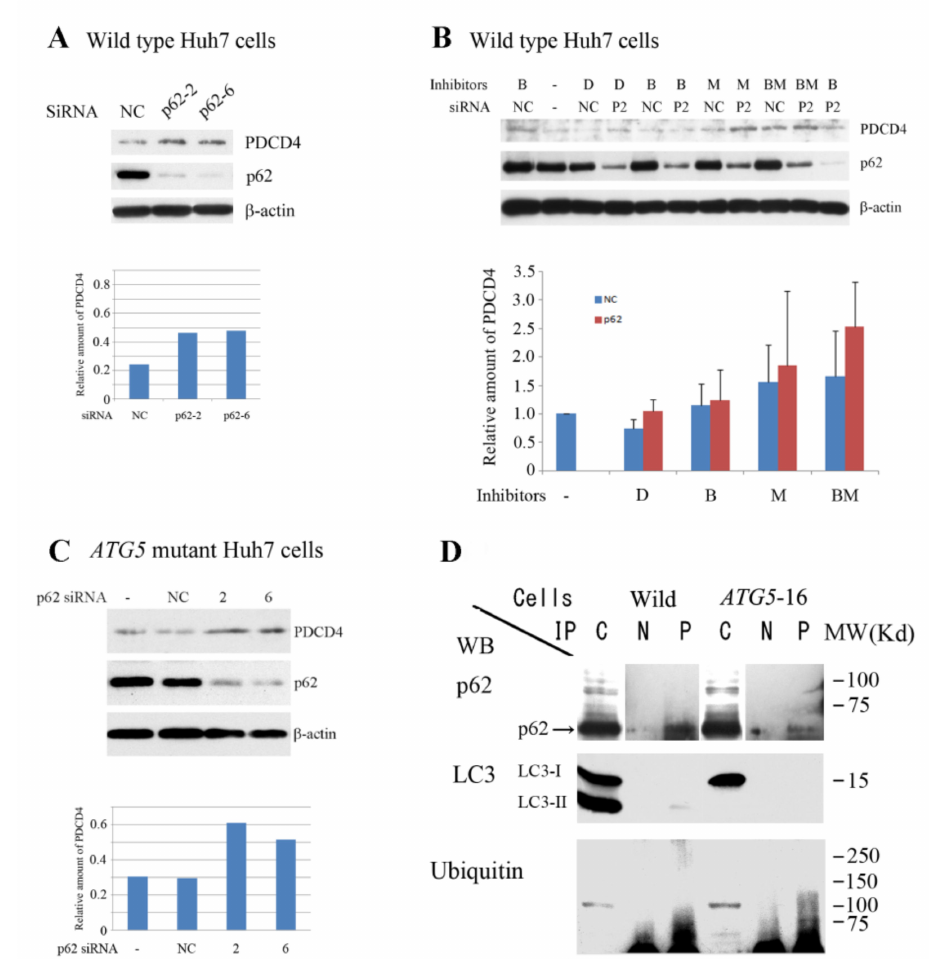
Figure 6. p62 was involved in PDCD4 degradation. ( A ) Knockdown of p62 upregulated the PDCD4 levels. Knockdown of p62 / SQSTM1 in Huh7 cells was performed using two di ff erent SQSTM1 siRNAs (p62-2 and p62-6). One dish was treated with negative control (NC) siRNA as a control. Upper panel, Western blotting analyses. Lower panel, diagram of the amount of PDCD4 obtained based on the PDCD4 bands in the upper panel. This experiment was performed twice, and similar results were obtained repeatedly. ( B ) After 24 h of p62 knockdown, the cells were treated with di ff erent inhibitors: Figure 4. Upper panel, Western blotting analyses. The experiment was repeated three times, and a representative figure is shown. Lower panel, diagram of the amount of PDCD4 obtained from the Western blotting analyses. Although MG132 (M) as well as bafilomycin A1 and MG132 (BM) upregulated the PDCD4 levels, bafilomycin A1 (B) alone was unable to upregulate this protein in p62 knockdown cells. ( C ) p62 knockdown also upregulated the PDCD4 levels in ATG5 mutant cells. The same protocol described in (A) was followed for the knockdown of p62 in ATG5 mutant cells using p62 siRNAs 2 and 6. This experiment was performed twice, and similar results were obtained repeatedly. ( D ) p62 and LC3-II were co-immunoprecipitated with PDCD4. Extracts of wild and ATG5 mutant Huh7 cells were immunoprecipitated with anti-PDCD4 antibody and the precipitates were analyzed by Western blotting using anti-p62, LC3 and ubiquitin antibodies. p62 and ubiquitin bands were observed in both cell types, but no LC3-II band was observed in the precipitate of mutant cells. Experiments were repeated more than three times and the representative figure is